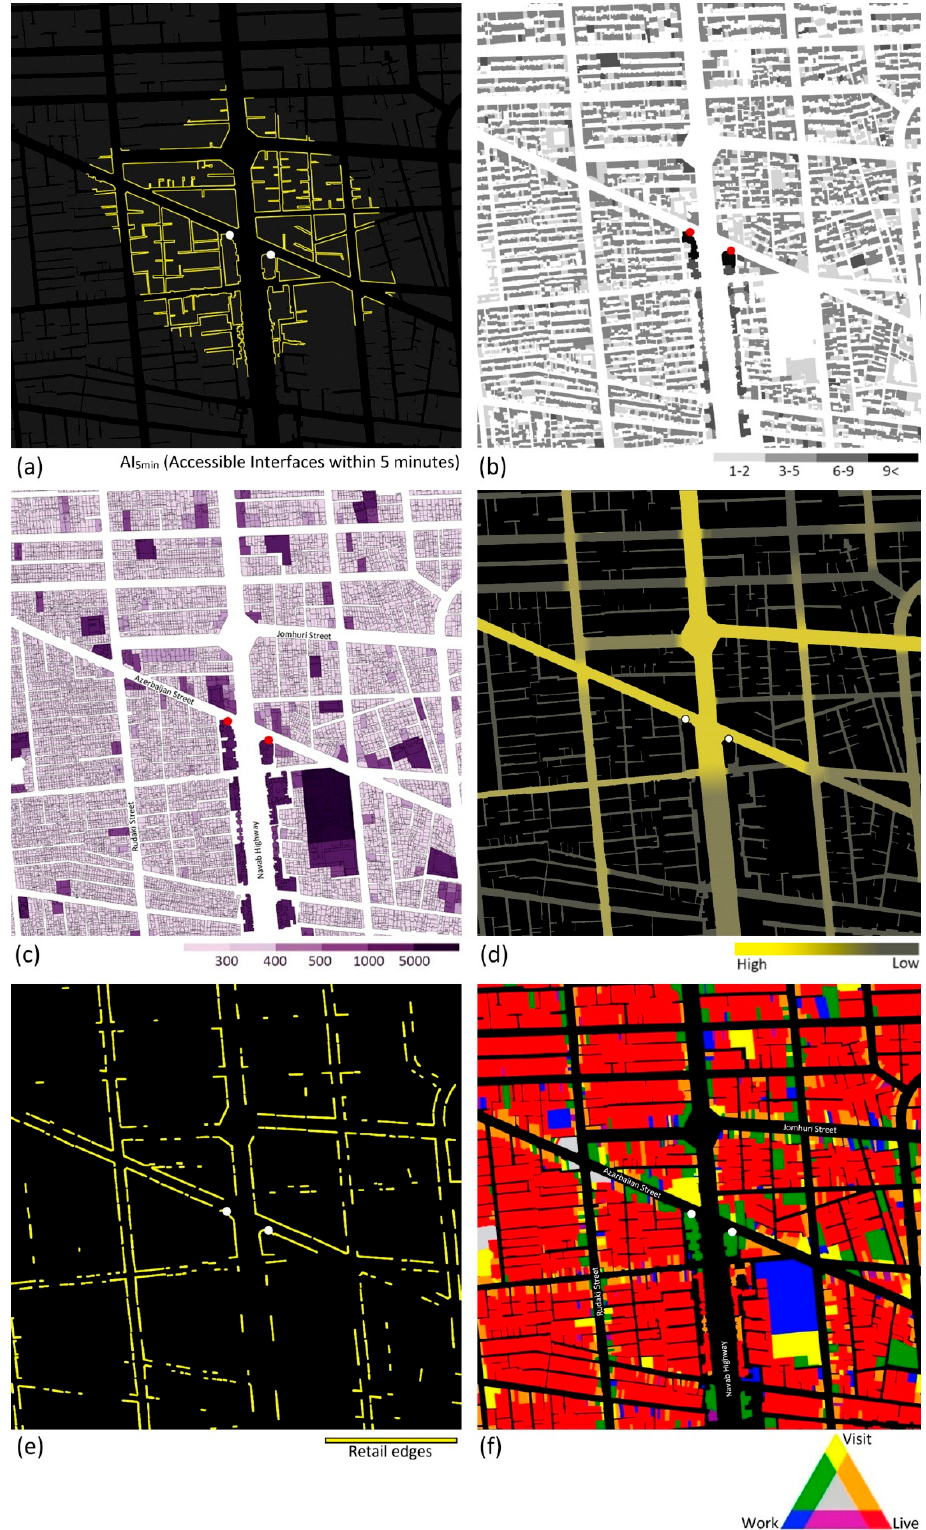
Figure 6. AI 5min ( a ), building heights ( b ), grain size ( c ), pedestrian flows ( d ), retail edges ( e ), and functional mix ( f ). The West: Navab. Scale: 1 km × 1 km. Maps: Nastaran Peimani.